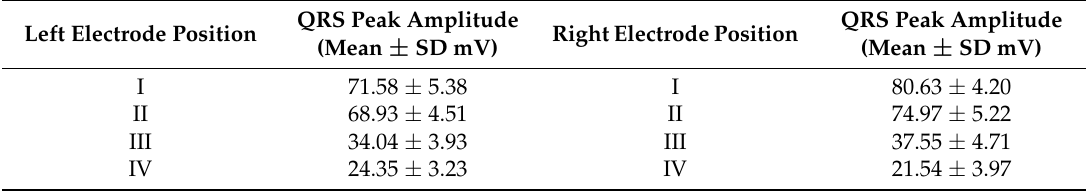
Figure 10. Different electrode positions. Table 1. QRS peak amplitude results.